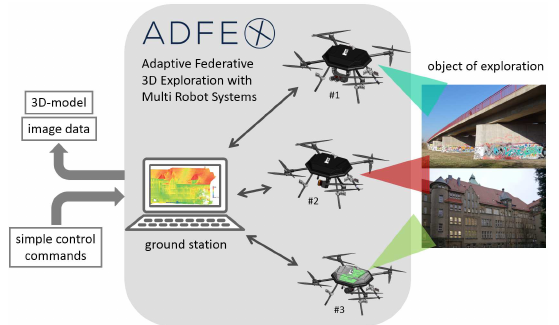
Figure 1: System design of ADFEX project. The capturing sys- tem consists of three UAVs equipped with special sensors and a ground